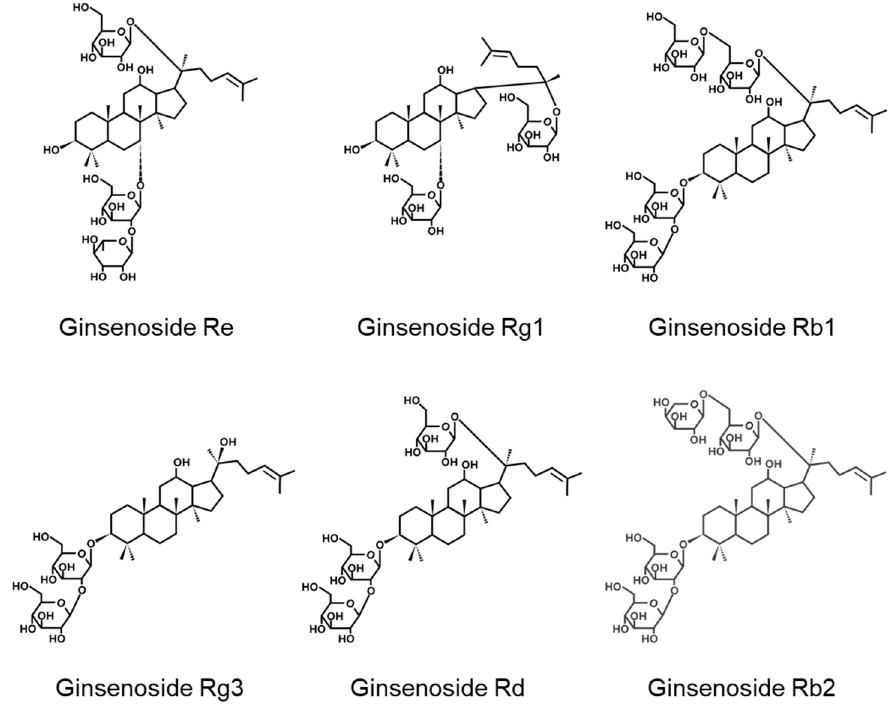
Figure 1. Chemical structures of ginsenosides.